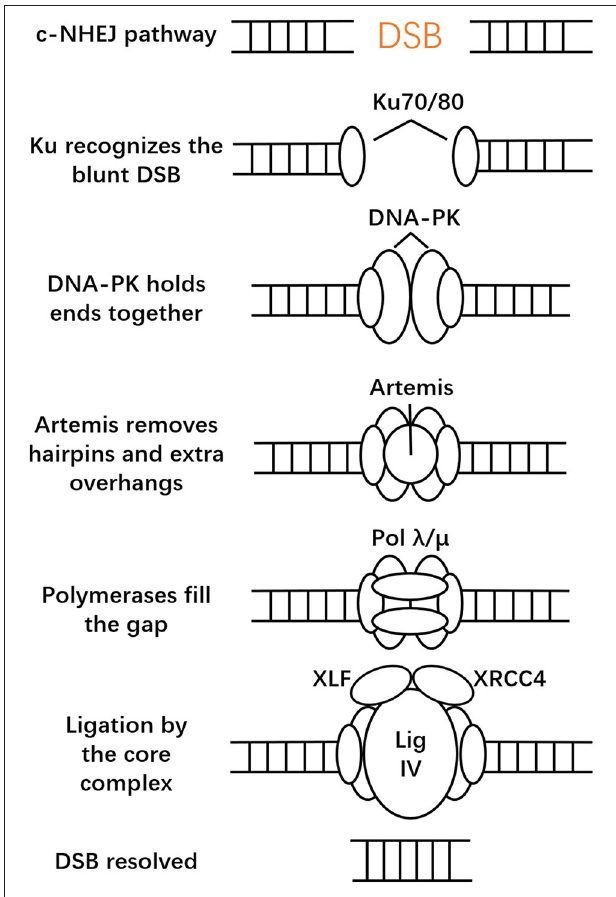
FIGURE 1 | Canonical non-homologous end joining (c-NHEJ). After CRISPR-Cas9 introduced a DSB, NHEJ is initiated by the binding of the Ku heterodimeric complex. This then forms the core complex, which is considered to recognize broken ends and keeps them together. The ends will then be ligated by various